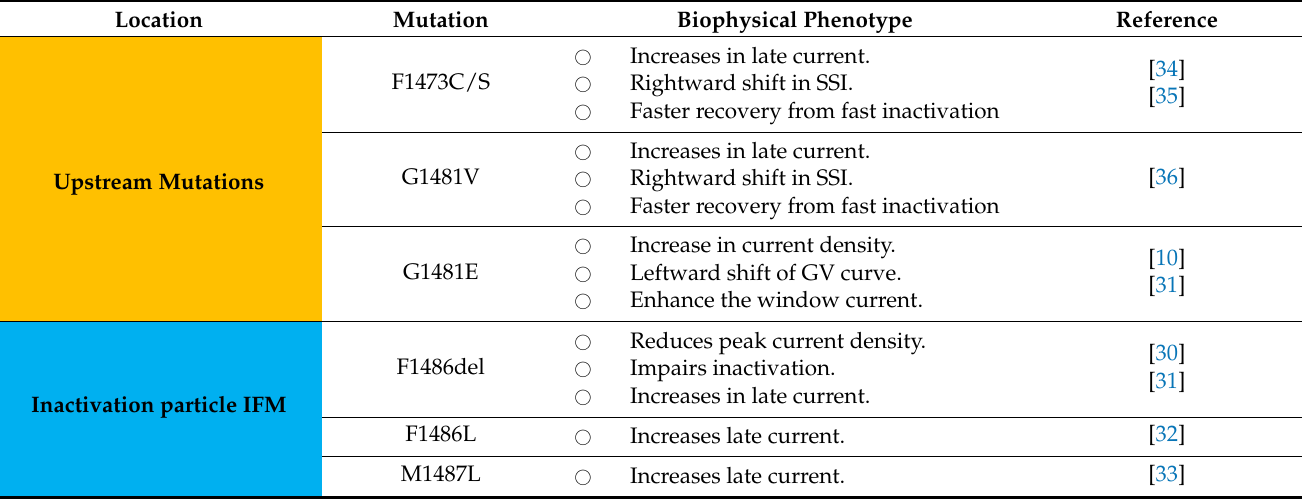
Table 1. The most important Upstream (USM) and Downstream (DSM) muttions that target the inactivation gates of Na v